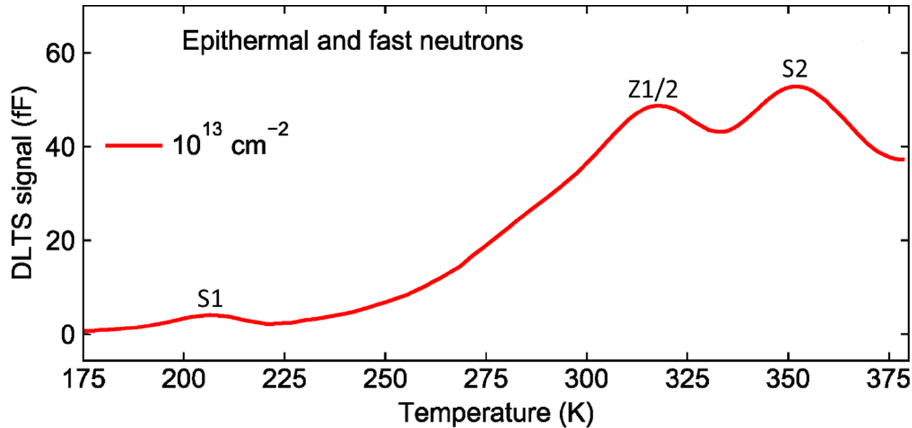
Figure 6. DLTS spectrum for the n-type 4H-SiC SBD irradiated with epithermal and fast neutrons. The neutron fluence was 10 13 cm − 2 . The data are adapted from Ref. [29].